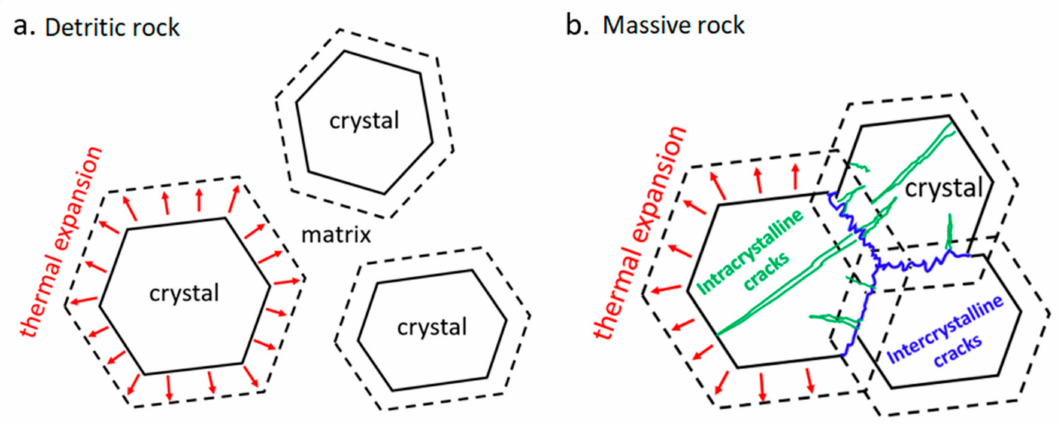
Figure 4. Effects produced by thermal expansion in detritic rocks ( a ) and massive rocks ( b